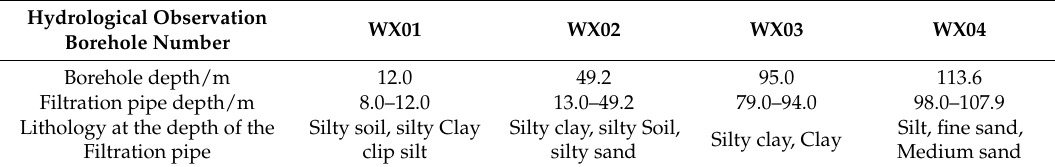
Table 1. Basic parameters for the hydrogeological drilling.